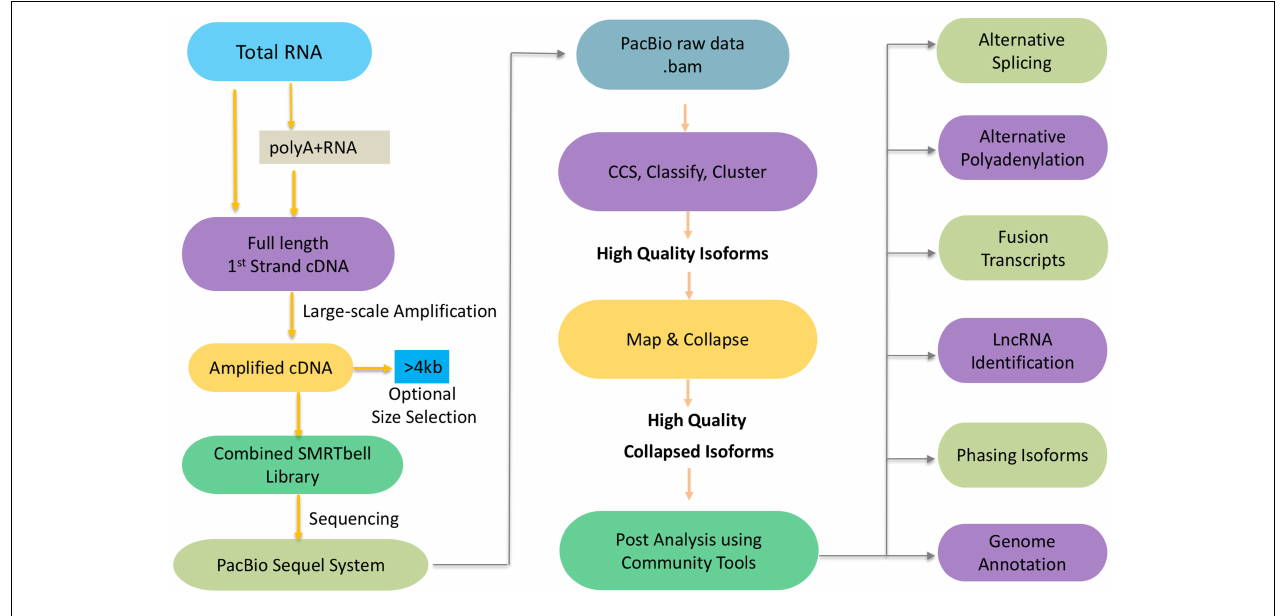
FIGURE 1 | Schematic workflow of